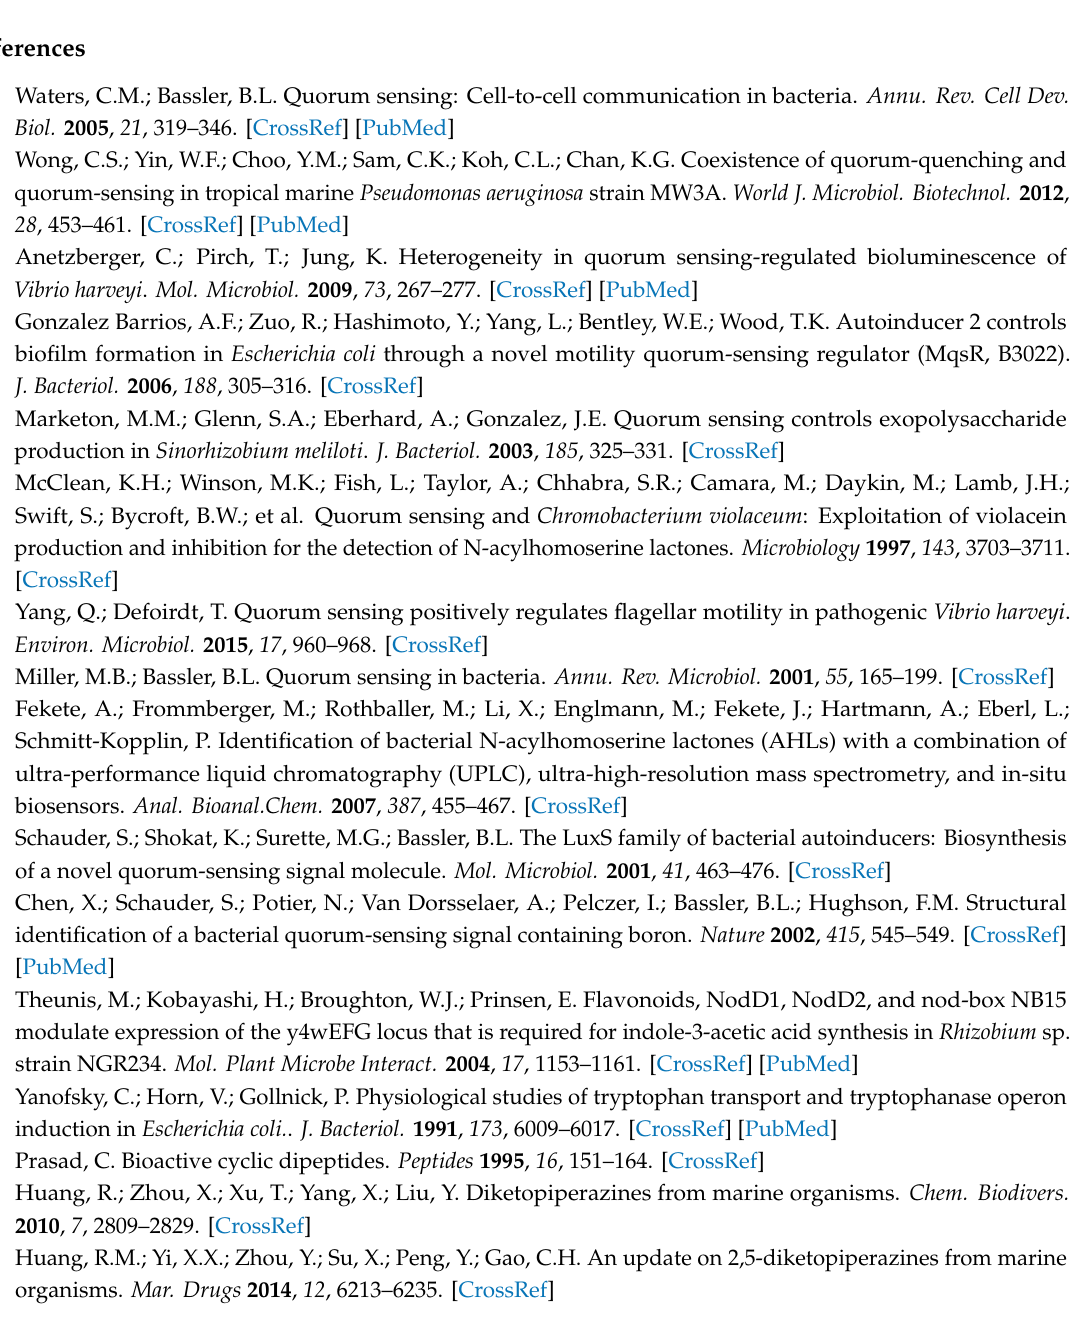
of each compound, Figure S6: HPLC analysis of signaling molecules, Figure S7: Agarose electrophoresis of the PCR-amplified NRPSs fragment, Figure S8: Agarose electrophoresis of PCR-amplified NRPSs fragment from the recombinant plasmid, Figure S9: The identification of mutant using PCR, Table S1: NMR data of compound 4, Table S2: NMR data of compound